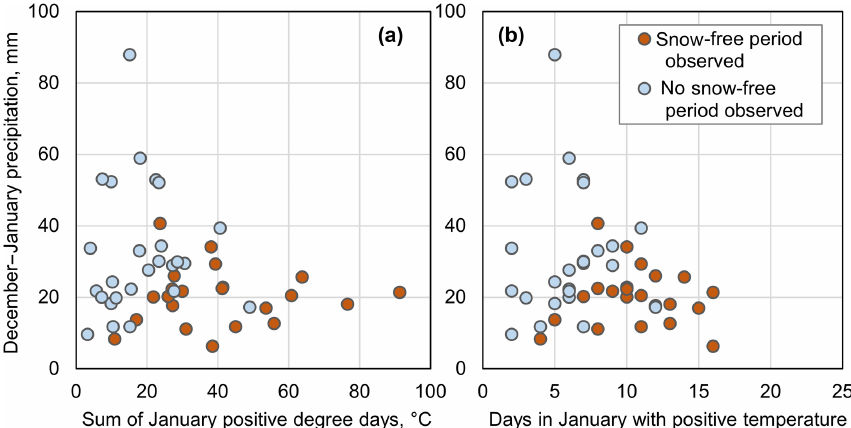
Figure 12. Effect of January warm spells and December–January precipitation on the occurrence of midwinter melts at long-term weather stations (Calgary, Olds, Lethbridge, and